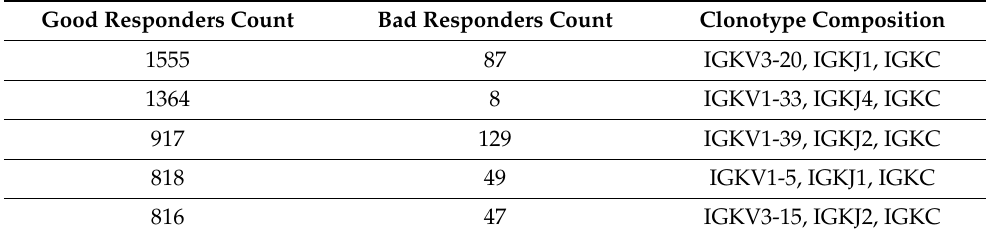
Table 1. Top 5 BCR clonotypes enriched in good responders to Nivolumab. Good Responders